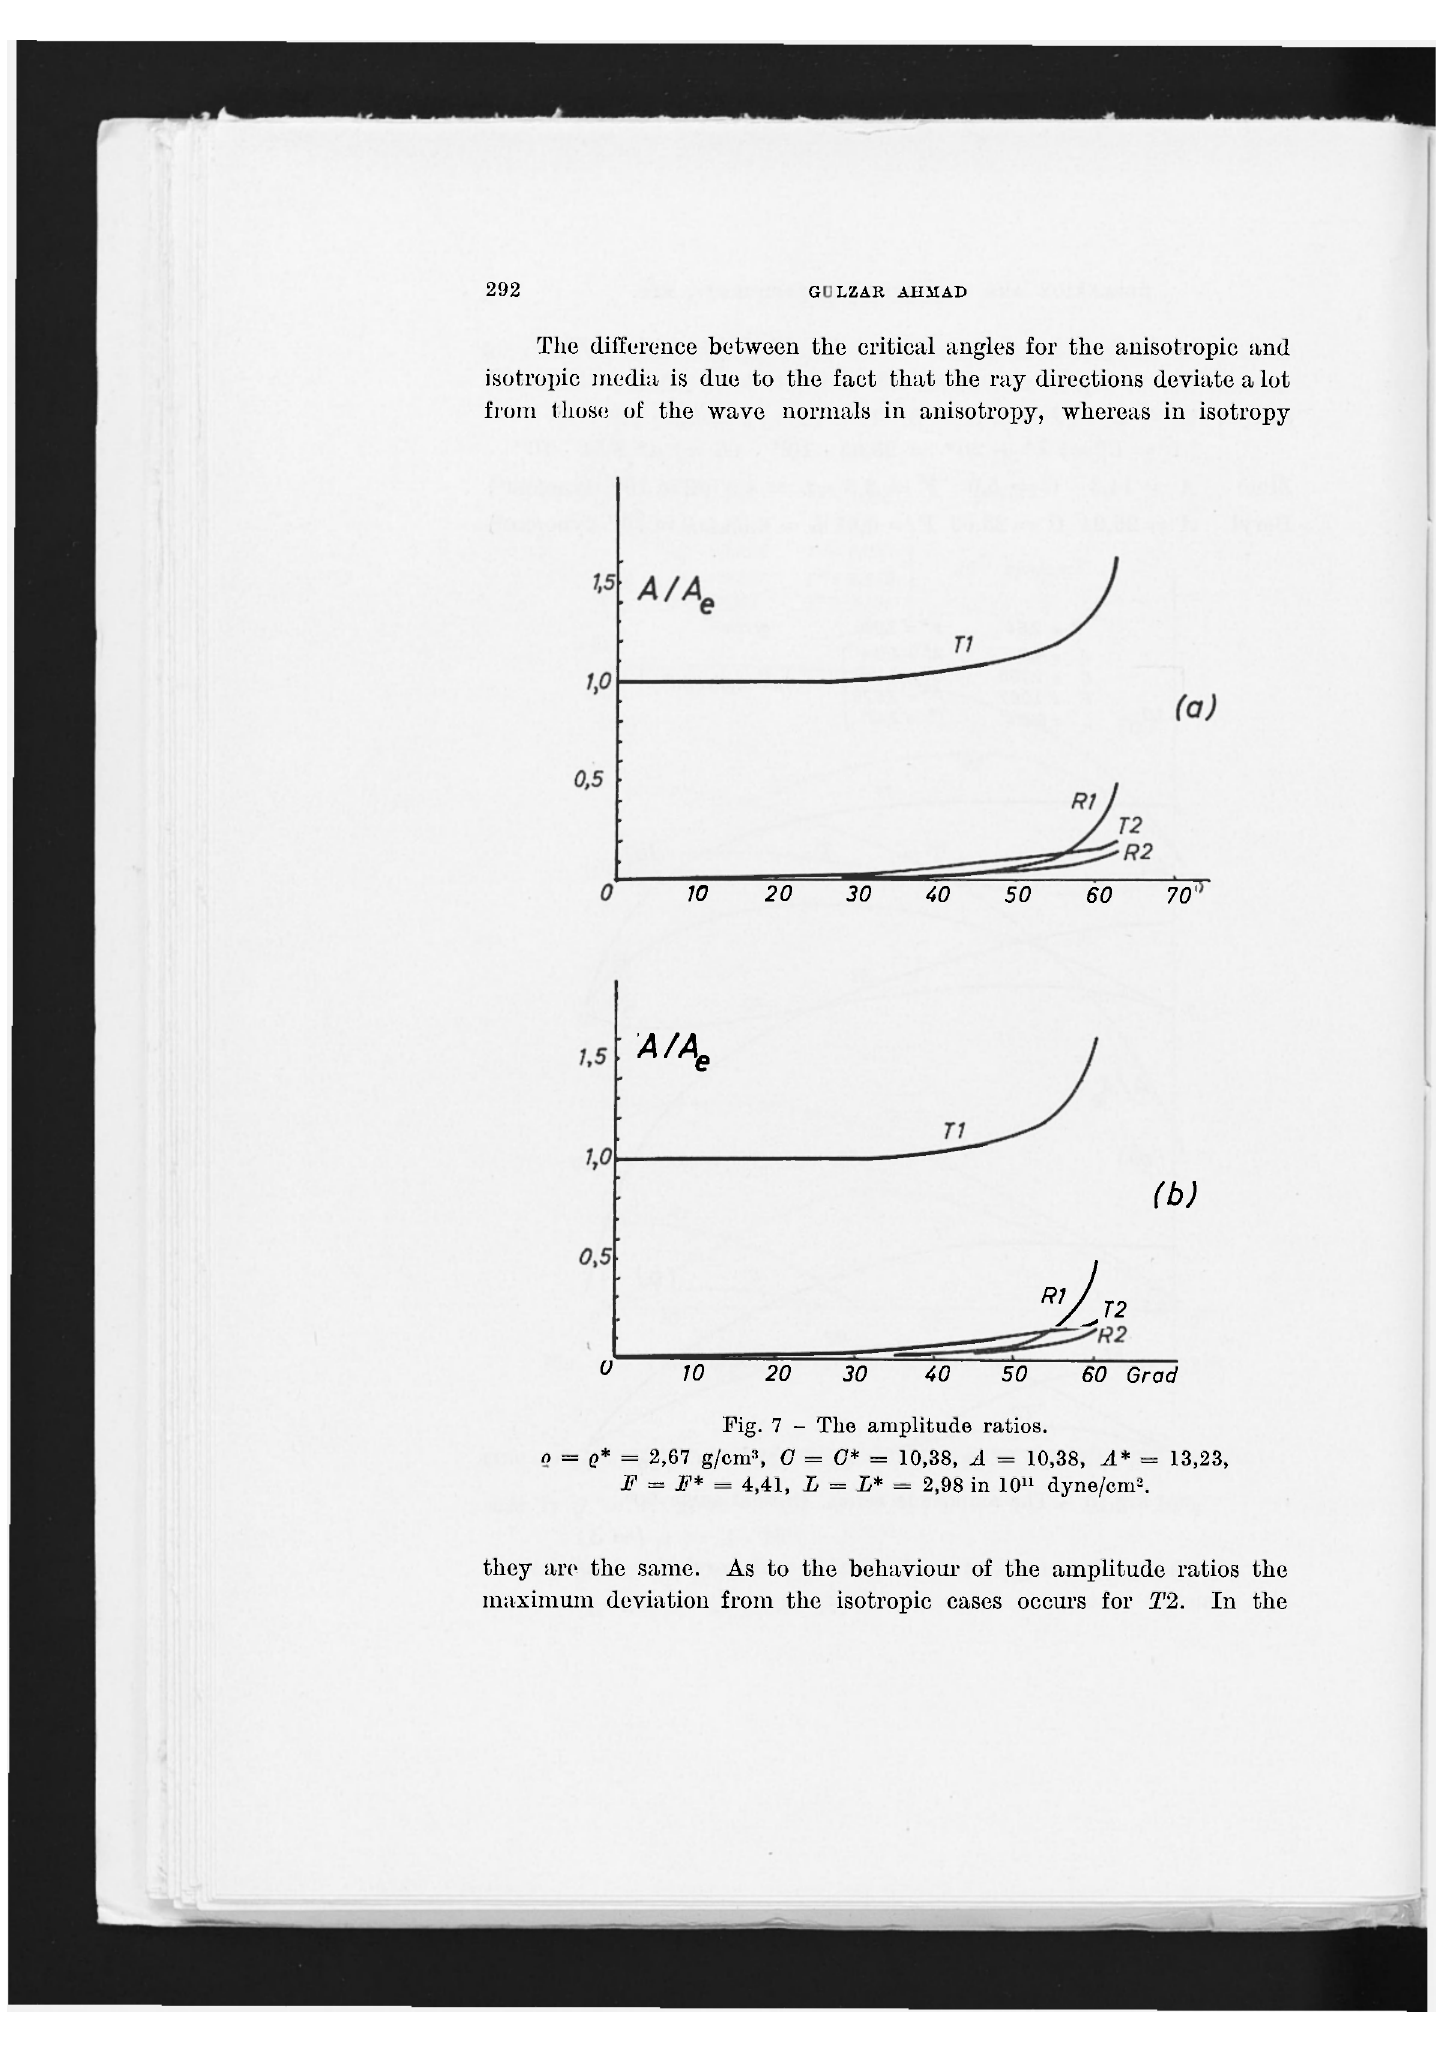
Fig. 7 - The amplitude